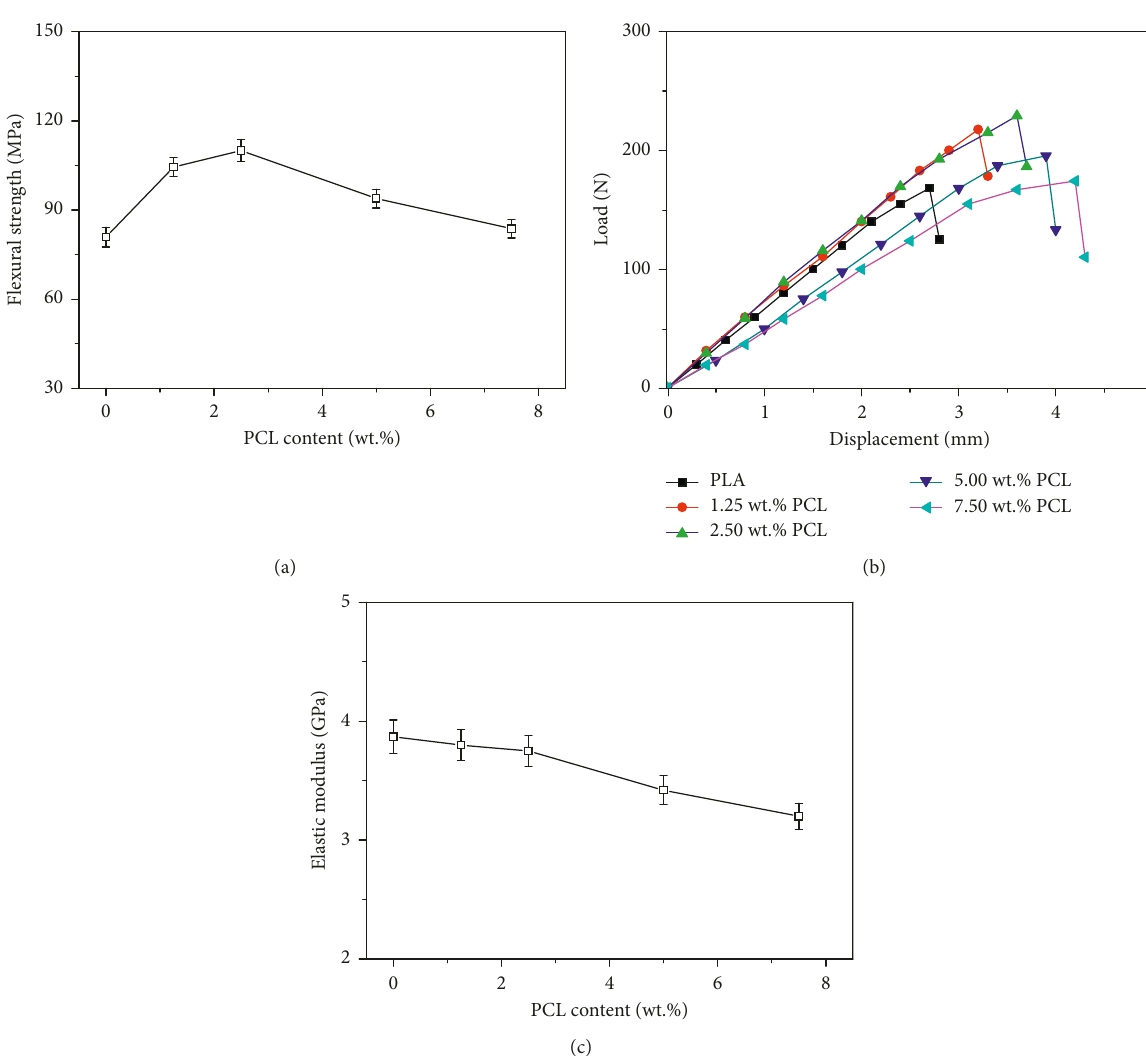
Figure 3: Flexural strength (a), load (b), and elastic modulus (c) of PLA/PCL